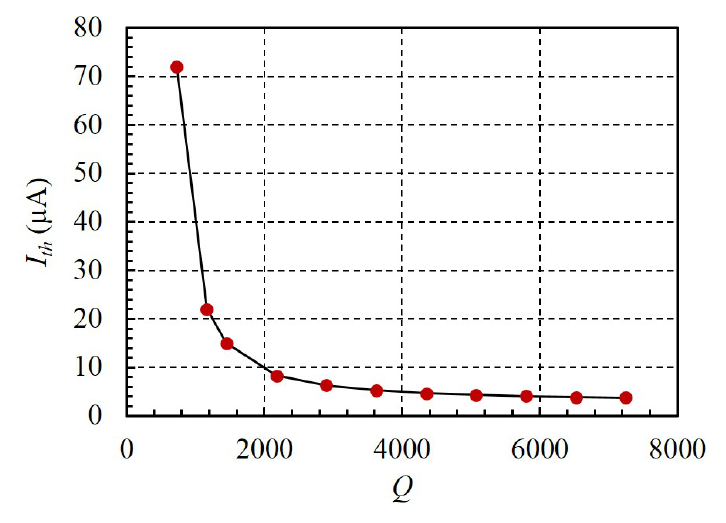
Figure 6. Lasing threshold ( I th ) versus Q for CirD lasers.